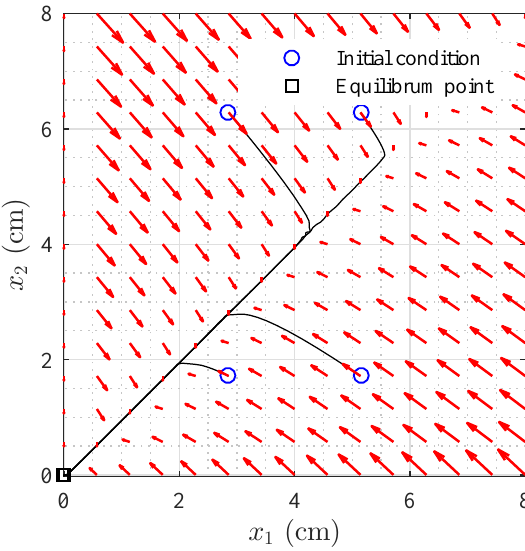
Figure 3. Phase portrait of the first two components of the